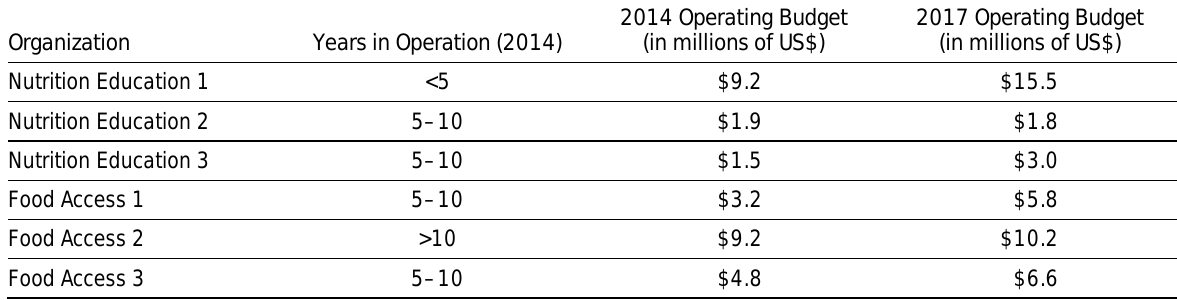
Table 1. Overview of Nutrition Cohort Member Organizations at the Time of Initial Funding (2014) and End of Funding Period